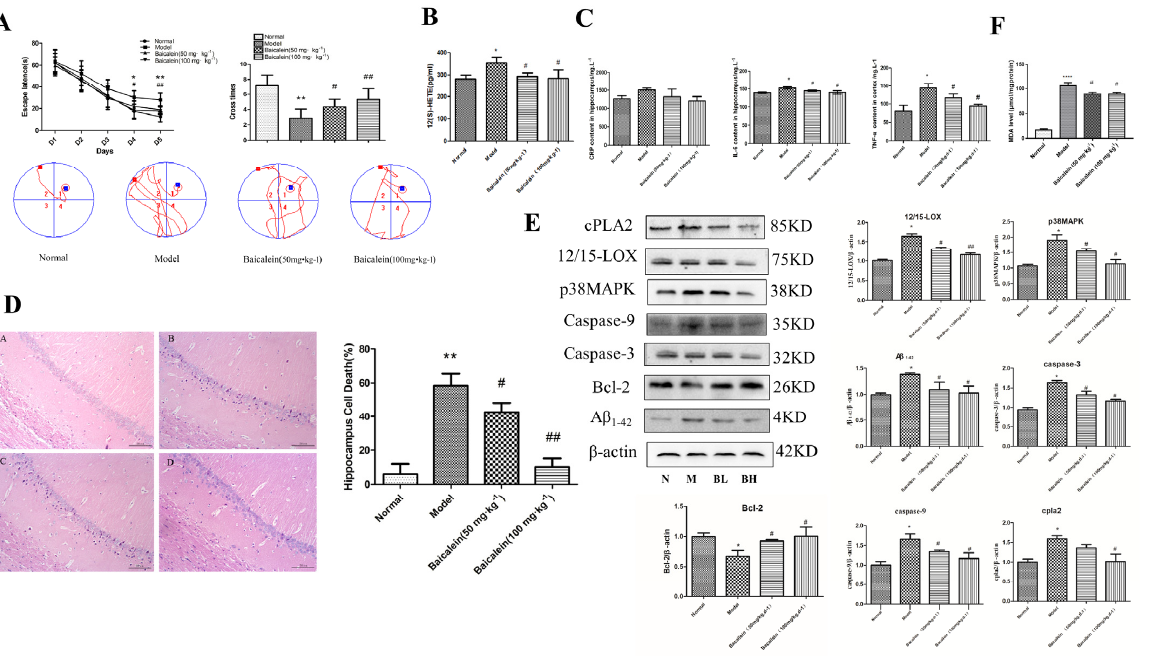
Figure 3. The effect and mechanism of 12/15-LOX in hippocampal injury in diabetic rats. Morris water maze test ( A ). The change in 12(S)-HETE in diabetic rats hippocampal ( B ). The change in inflammatory factor in diabetic rats hippocampal ( C ). Changes in hippocampal pathology diabetic rats ( D ). Changes in hippocampus-related proteins in diabetic rats ( E ). MDA level ( F ). * p < 0.05, ** p < 0.05 and **** p < 0.0001 compared with normal group; # p < 0.05, ## p < 0.01 compared with model group.